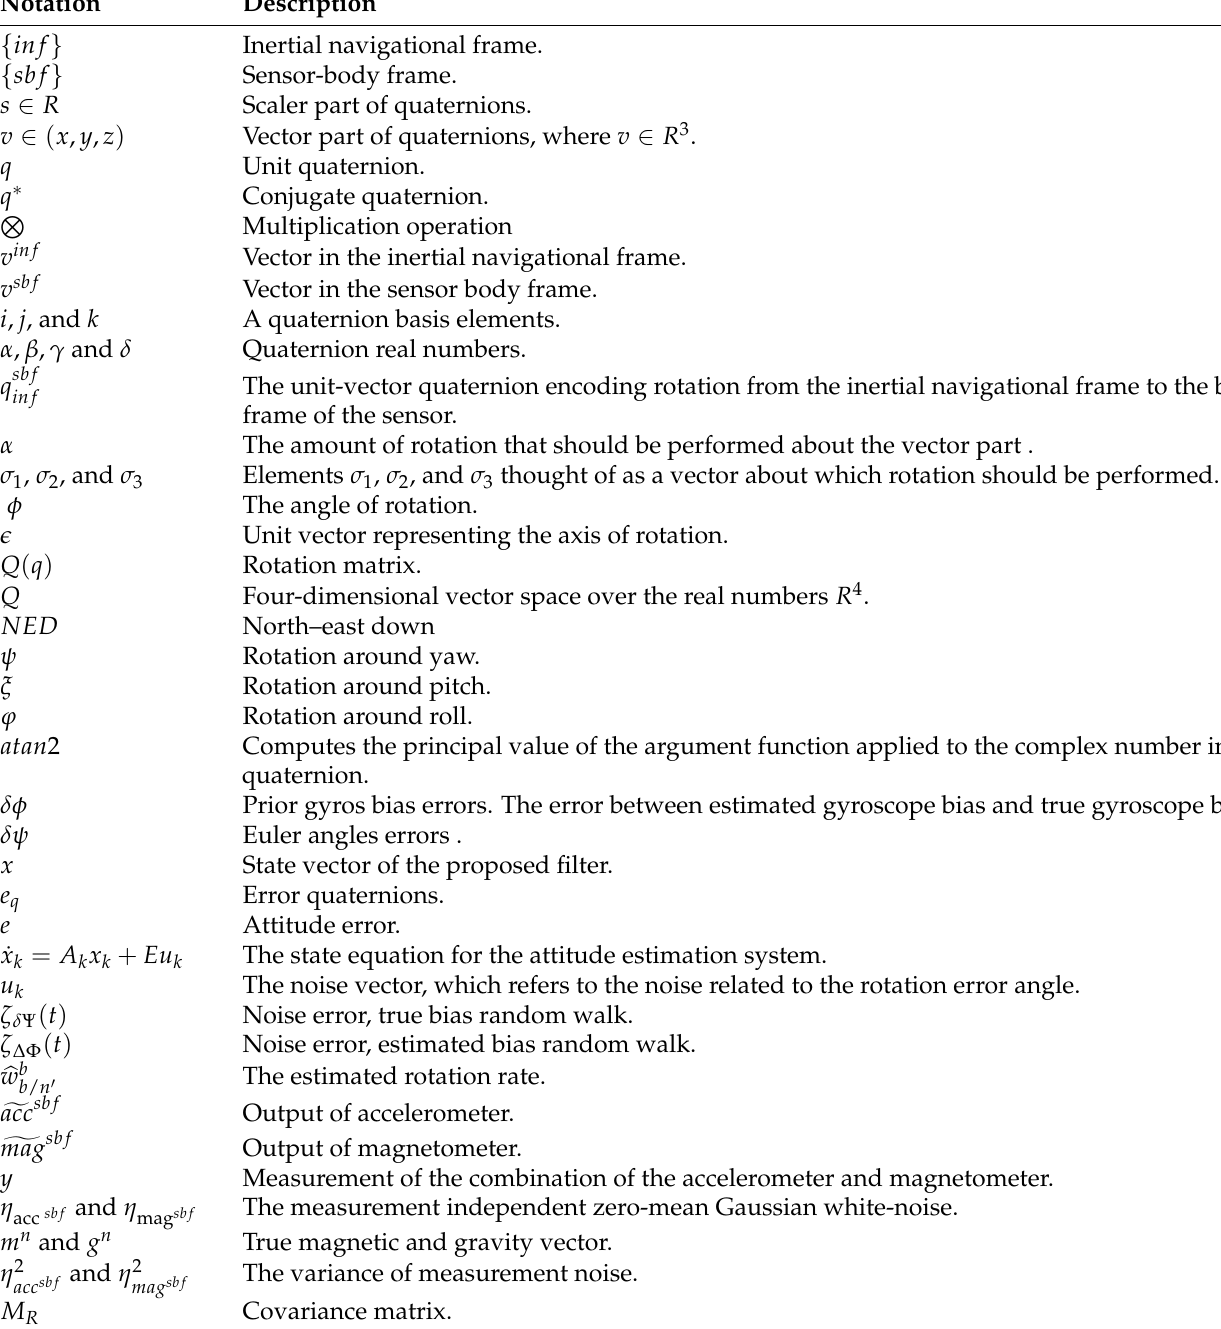
Table 2. Description of notations and symbols used in the